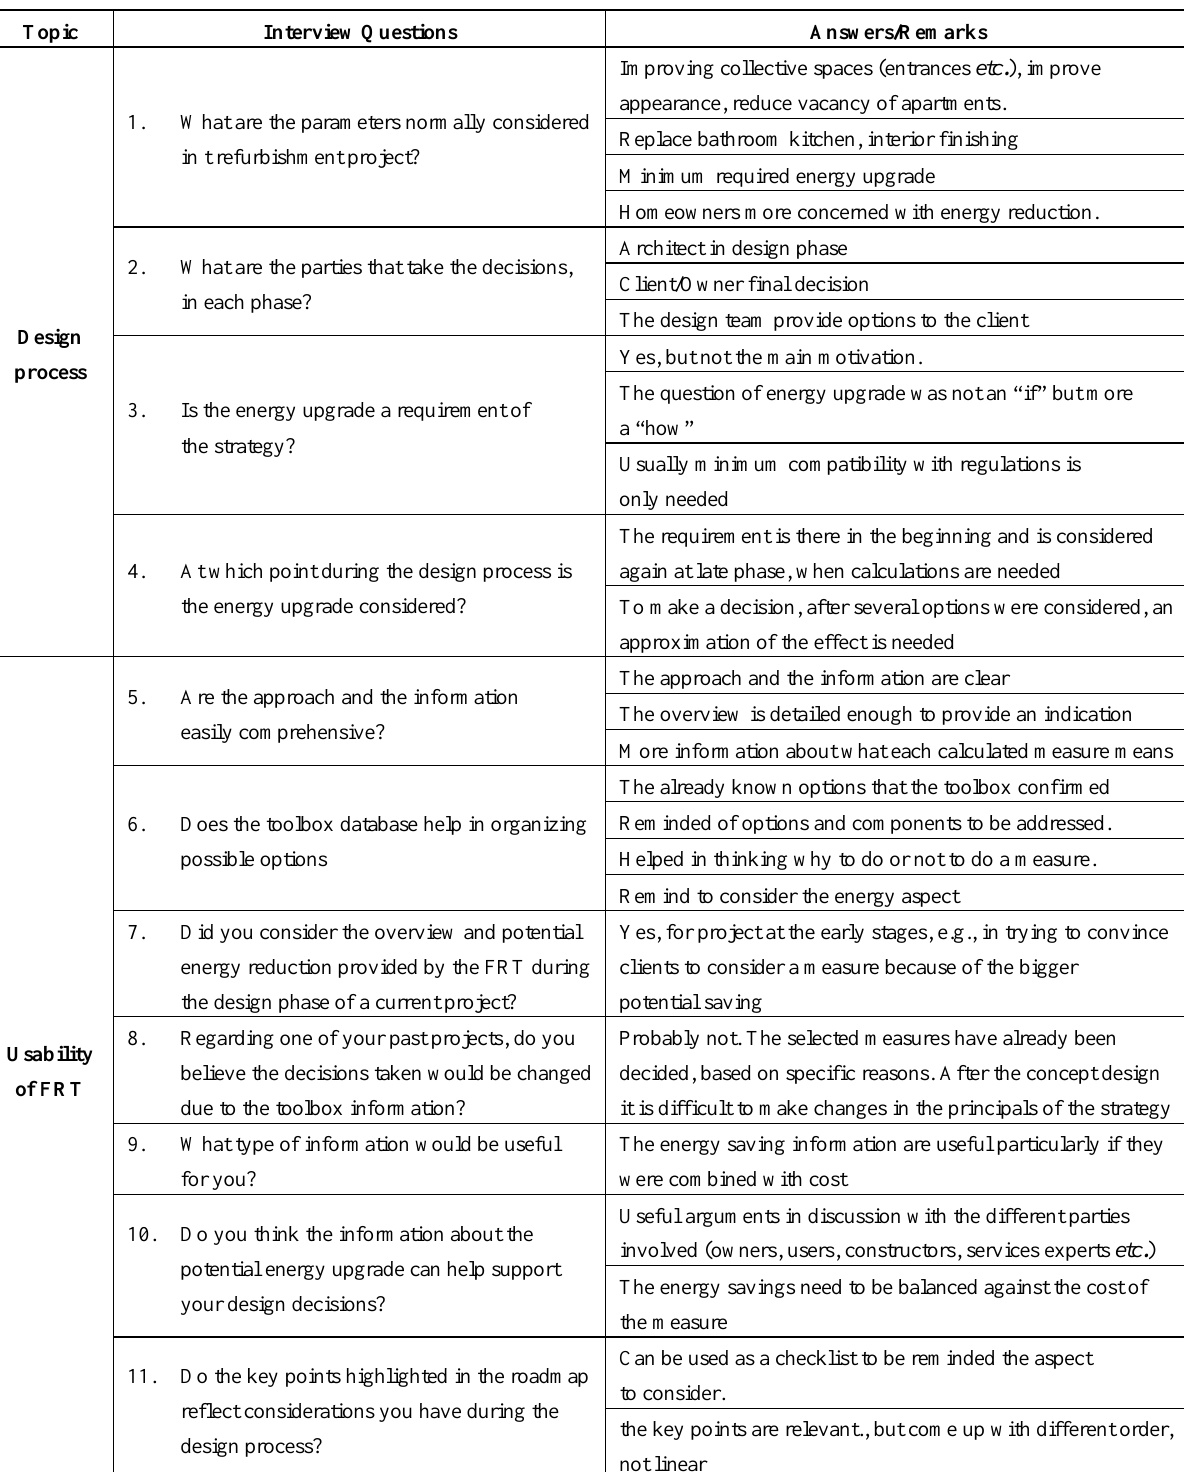
Table 5. Overview of the semi-structured interview questions and